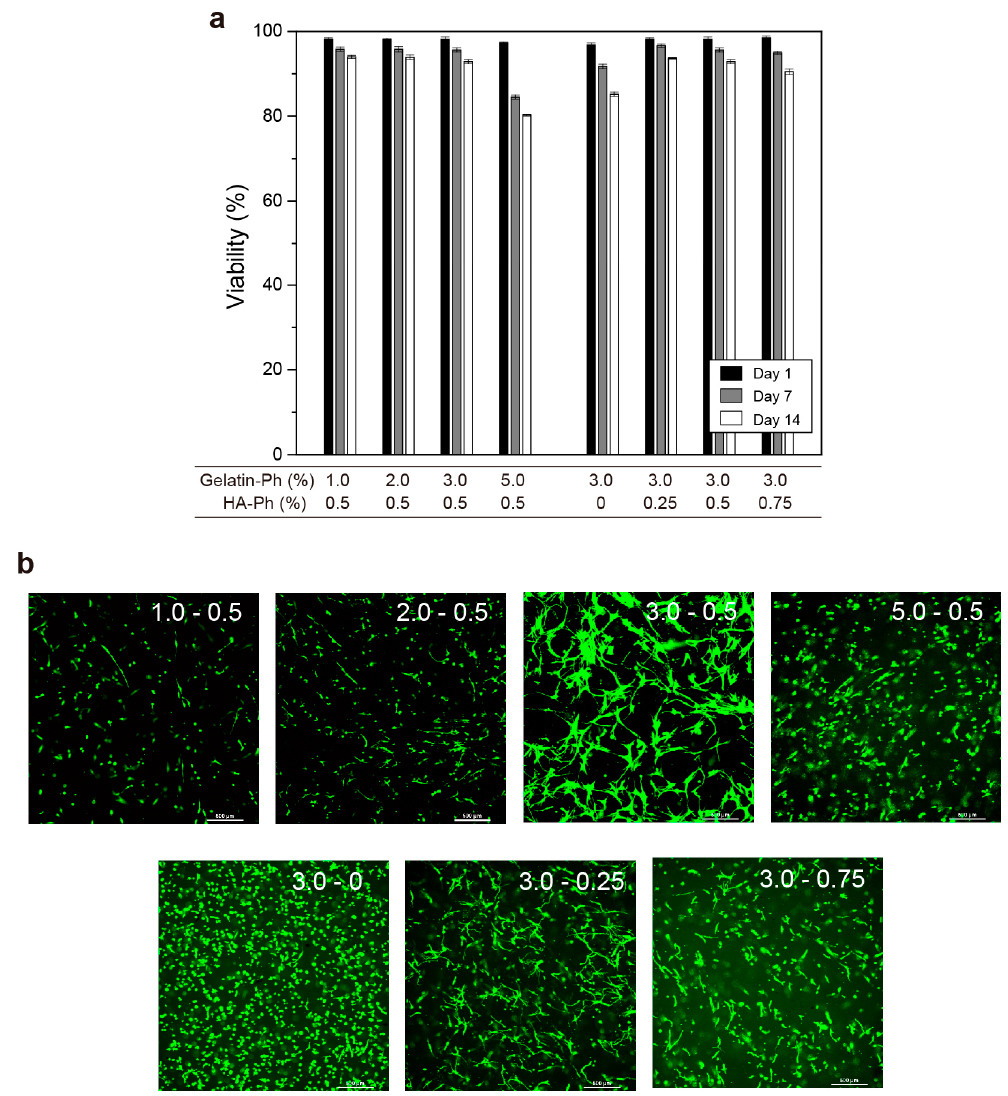
Figure 7. E ff ects of gelatin-Ph and HA-Ph content on ( a ) viability of hASCs during 14 days of culture (Bars: S.D., n = 3) and ( b ) morphology of enclosed hASCs at 7 days of culture (Bars: 500 µ m). Confocal fluorescence images in panel b were taken at a 400 to 500 µ m height from the bottom of the specimens (1 mm thickness) at 7 days of culture. The numerical characters in each image, X and Y, mean the contents of gelatin-Ph (%) and HA-Ph (%), respectively.